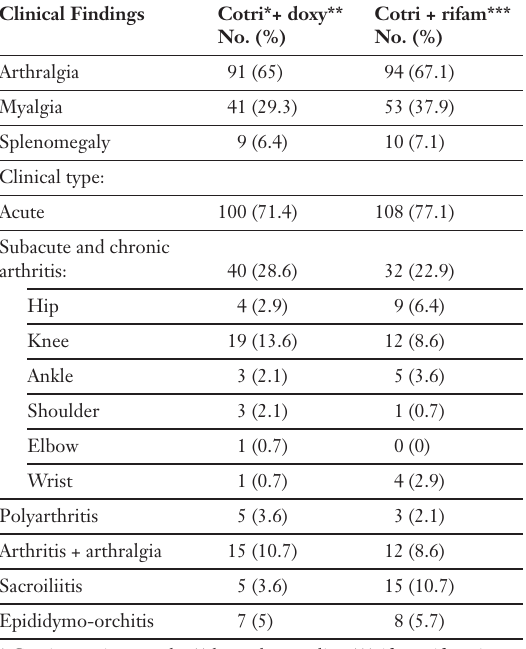
Clinical findings of patients treated with co-trimoxazole plus doxycycline or co-trimoxazole plus